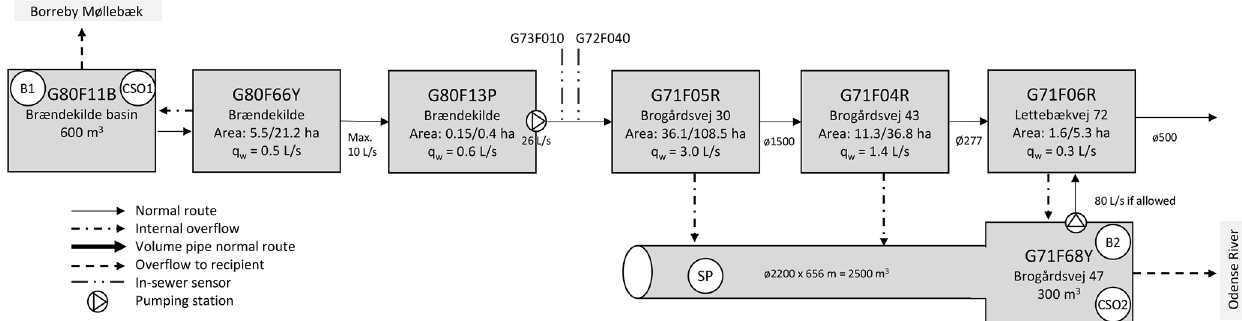
Figure 3. Conceptual illustration of the most important hydraulic structures in the urban drainage system. “Area” indicates the impervious area/total area connected to a structure, while q w is the average daily wastewater load connected to each structure. The total average daily wastewater discharge upstream of G71F06R is 5.8Ls − 1 (equal to 501m 3 d − 1 ). B: basin; CSO: combined sewer overflow; SP: storage